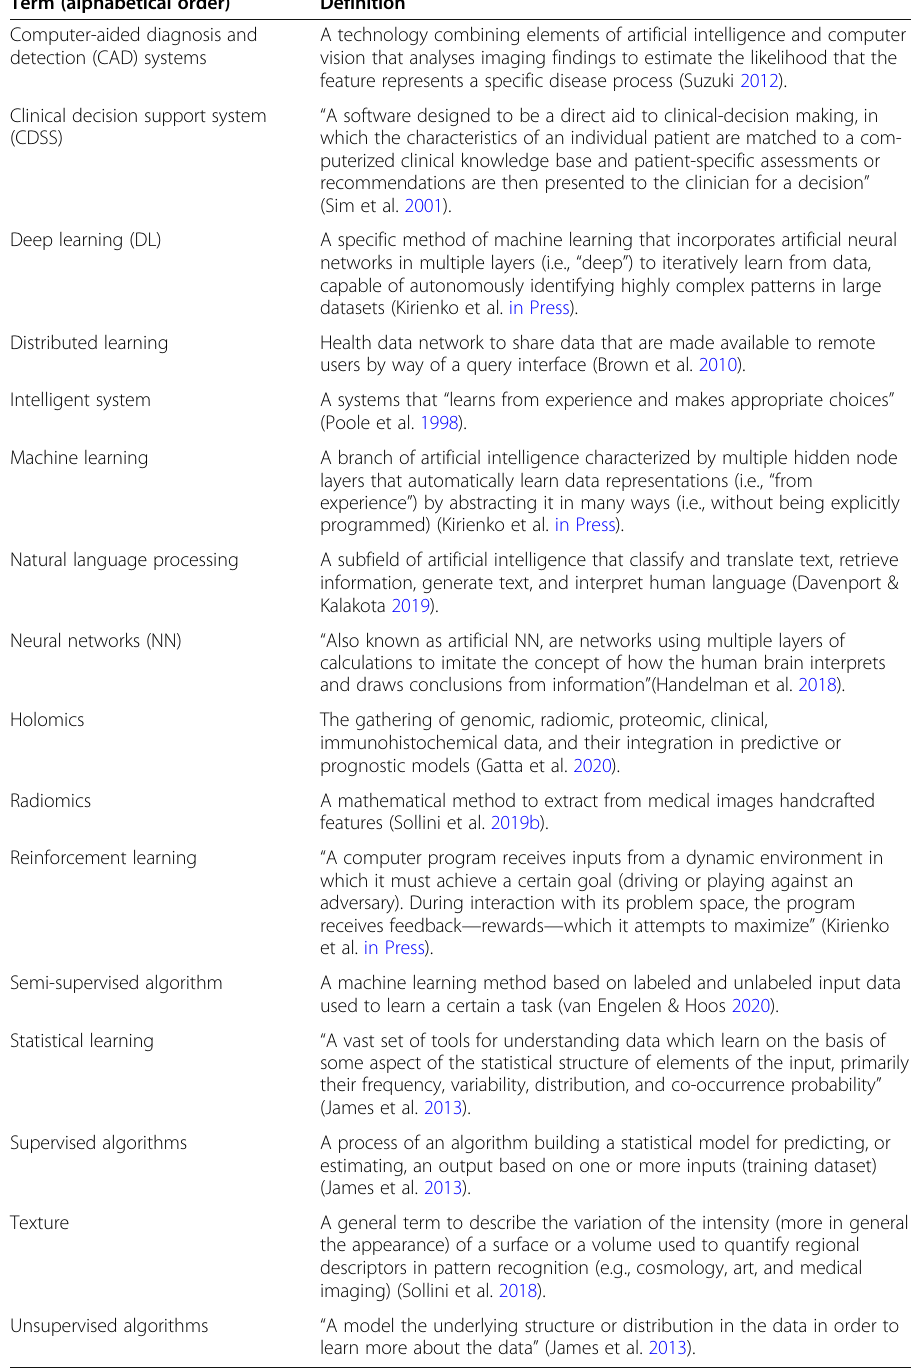
Table 1 Summary of the main definitions in the field of artificial intelligence (AI) Term (alphabetical